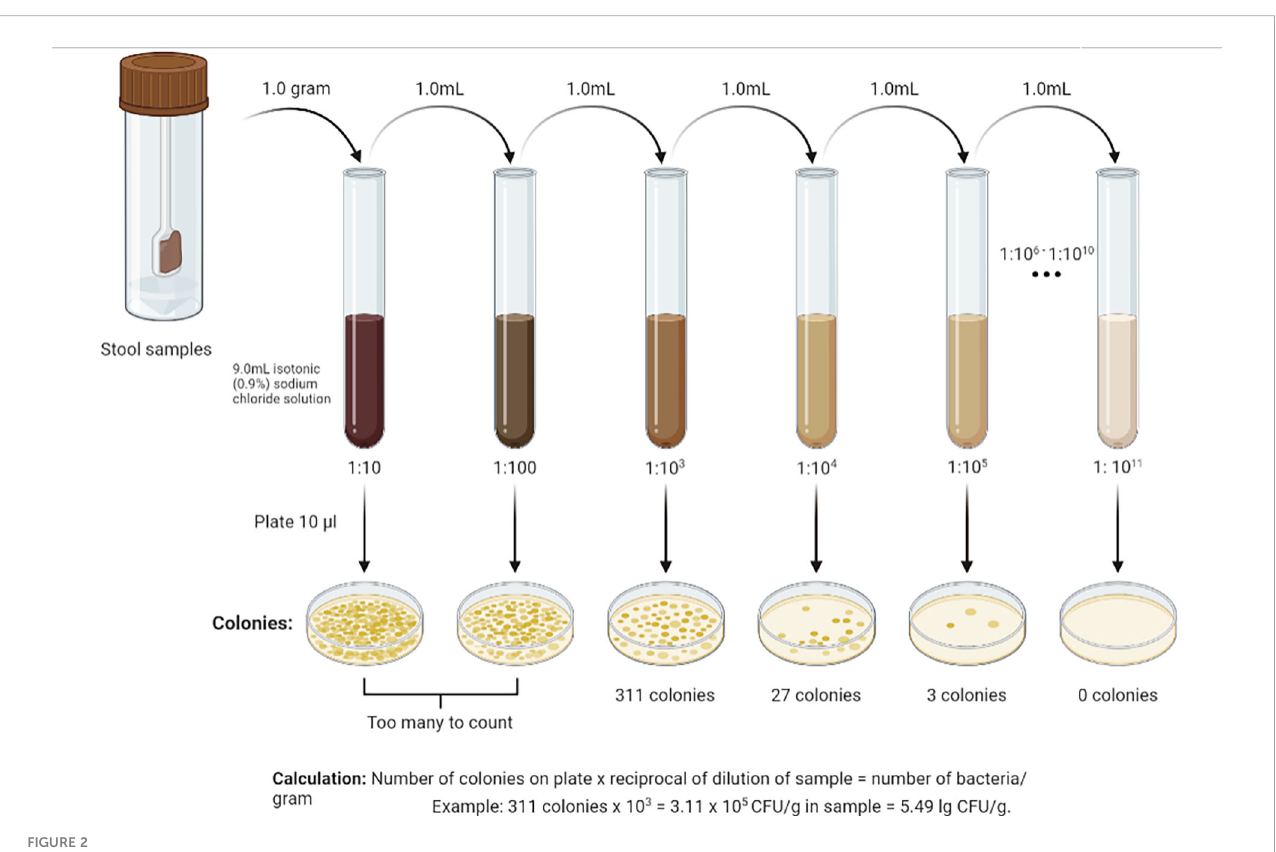
FIGURE 2 Methodology for serial dilution of stool